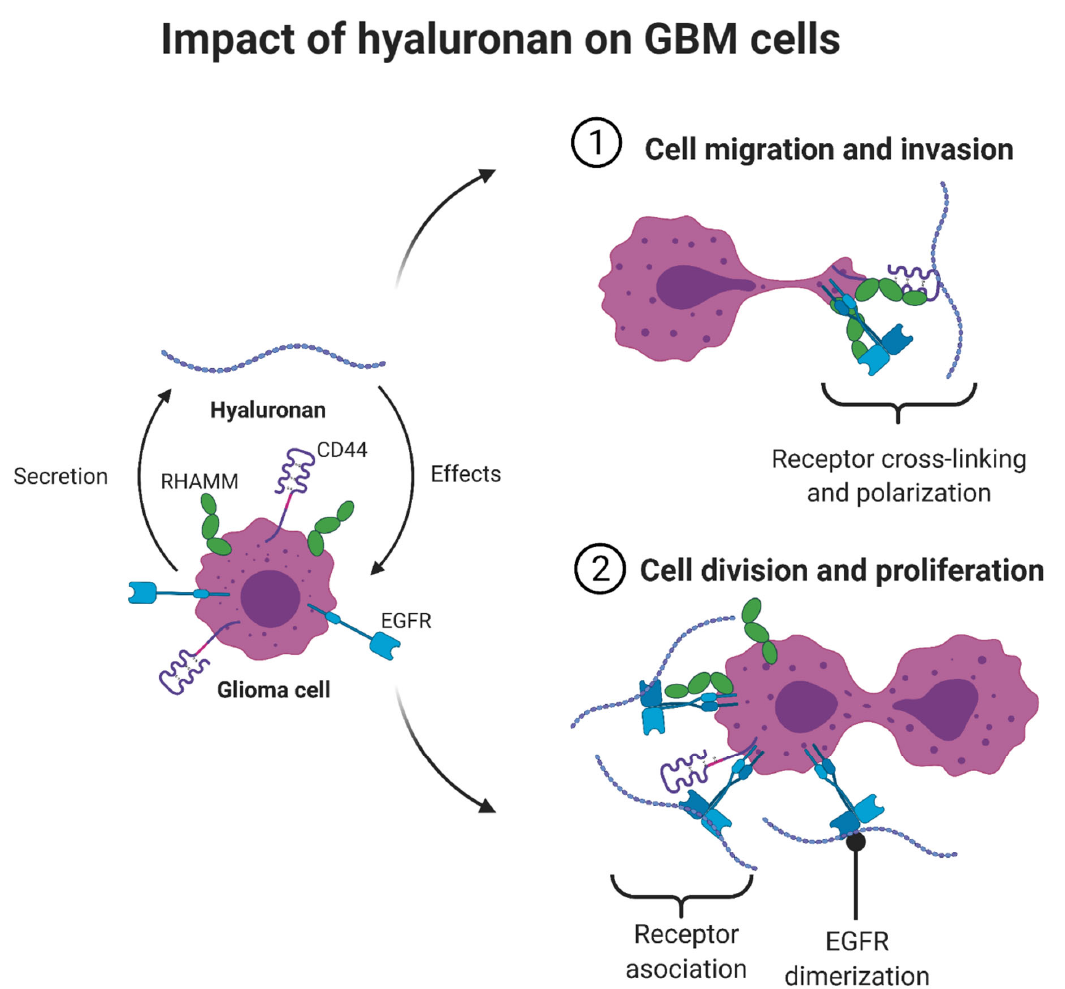
Figure 3. Impact of hyaluronic acid (HA) on GBM cells. HA, through increased expression of